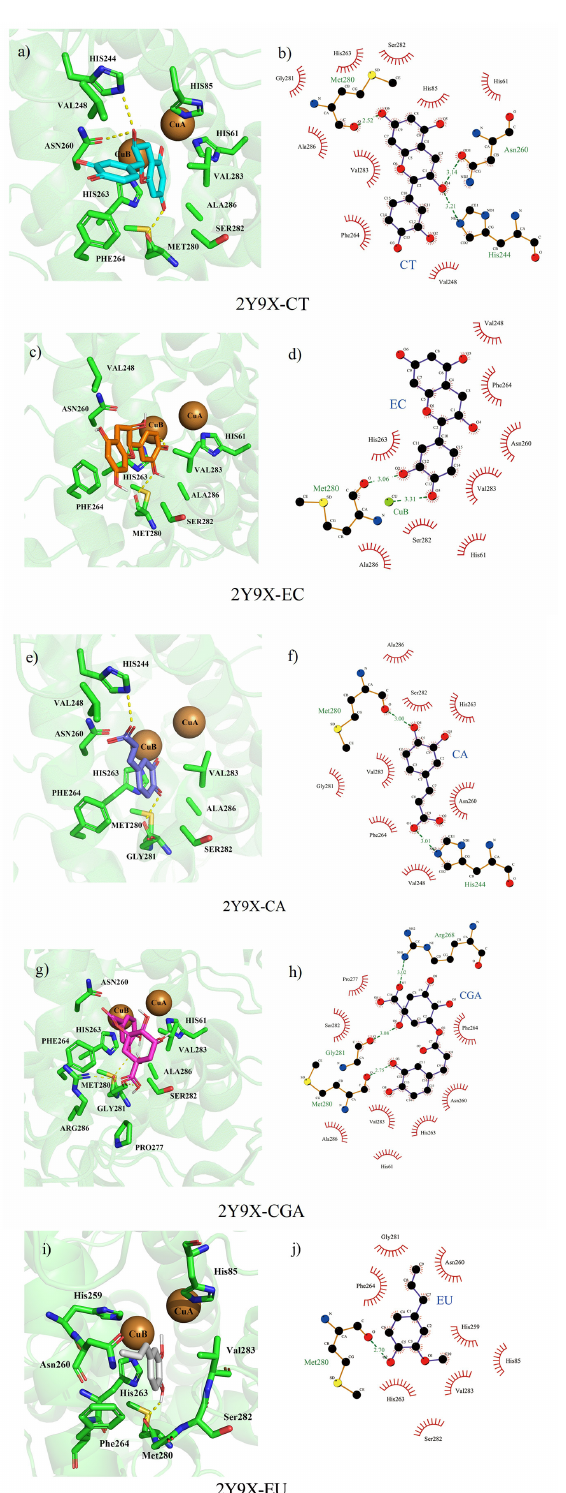
Figure 14. Molecular docking conformations of five compounds and tyrosinase. The image on the left is a 3D visual image, and the image on the right is a 2D visual image. ( a , b ) Detailed view of the binding mode between the catechin and the tyrosinase ( c , d ) Detailed view of the binding mode between the epicatechin and the tyrosinase ( e , f ) Detailed view of the binding mode between the caffeic acid and the tyrosinase ( g , h ) Detailed view of the binding mode between the chlorogenic acid and the tyrosinase ( i , j ) Detailed view of the binding mode between the eugenol and the